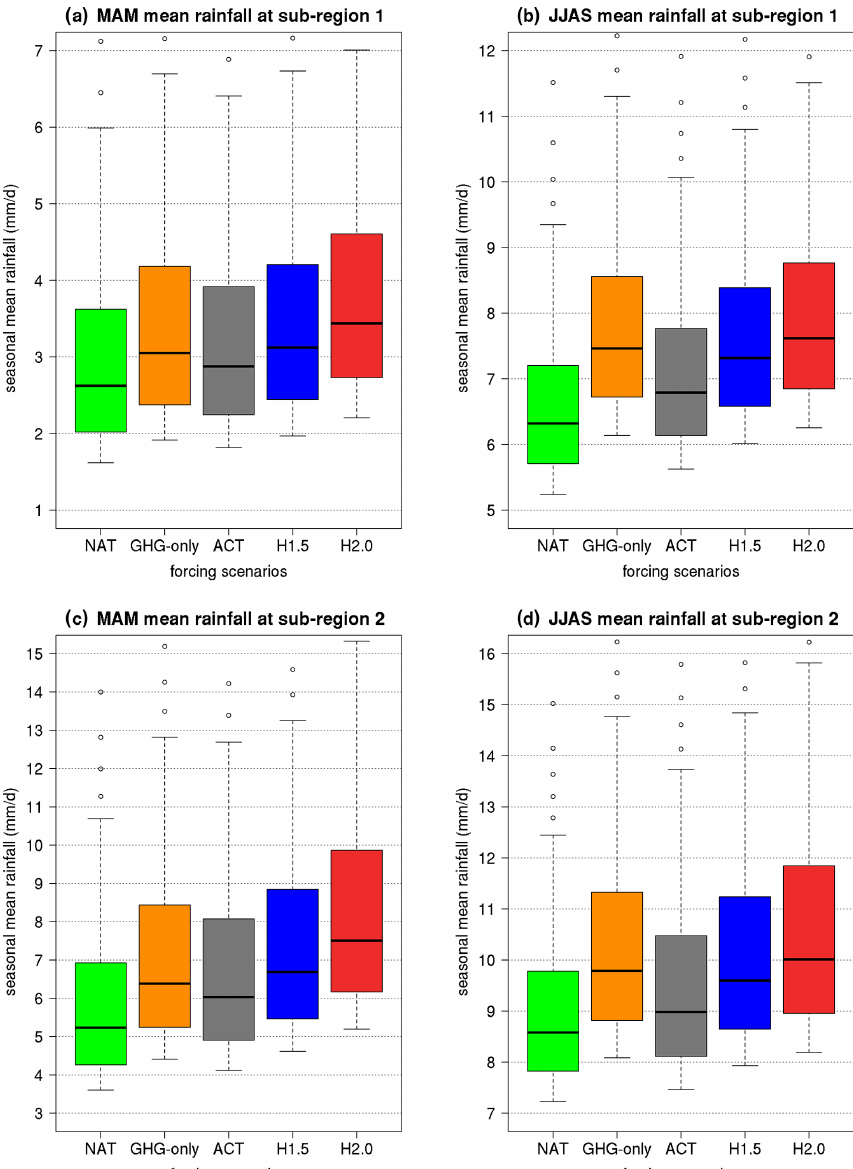
Figure 4. Seasonal mean rainfall in MAM (a, c) and JJAS (b, d) over the sub-regions 1 and 2 (top and bottom row) of Bangladesh. Green, orange, grey, blue, and red colours represent NAT, GHG-only, ACT, HAPPI 1.5, and HAPPI 2.0 ensembles, respectively. Each panel has different y scale to clearly indicate the details of changes in the median values between different model ensembles. The horizontal black line in each box indicates the median value, and the bottom and top limits of the box represent the 25th and 75th percentiles,